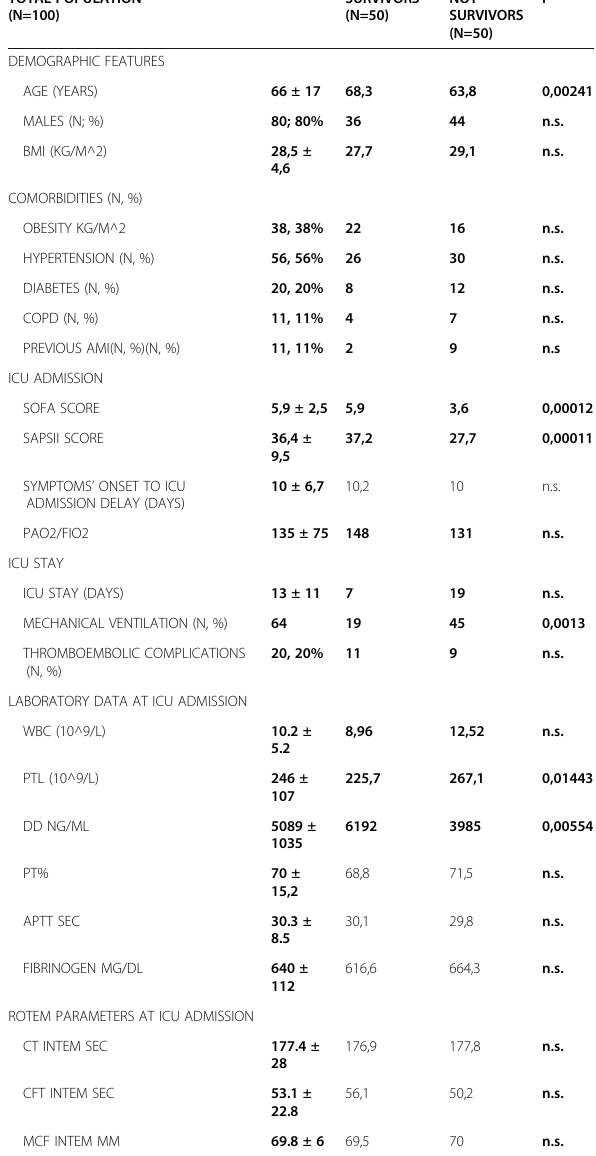
Table 1 (abstract A185). See text for description TOTAL POPULATION (N=100)